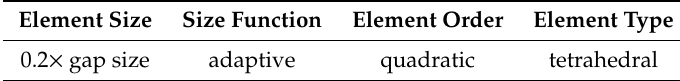
Table 3. Details of mesh data and characteristics.